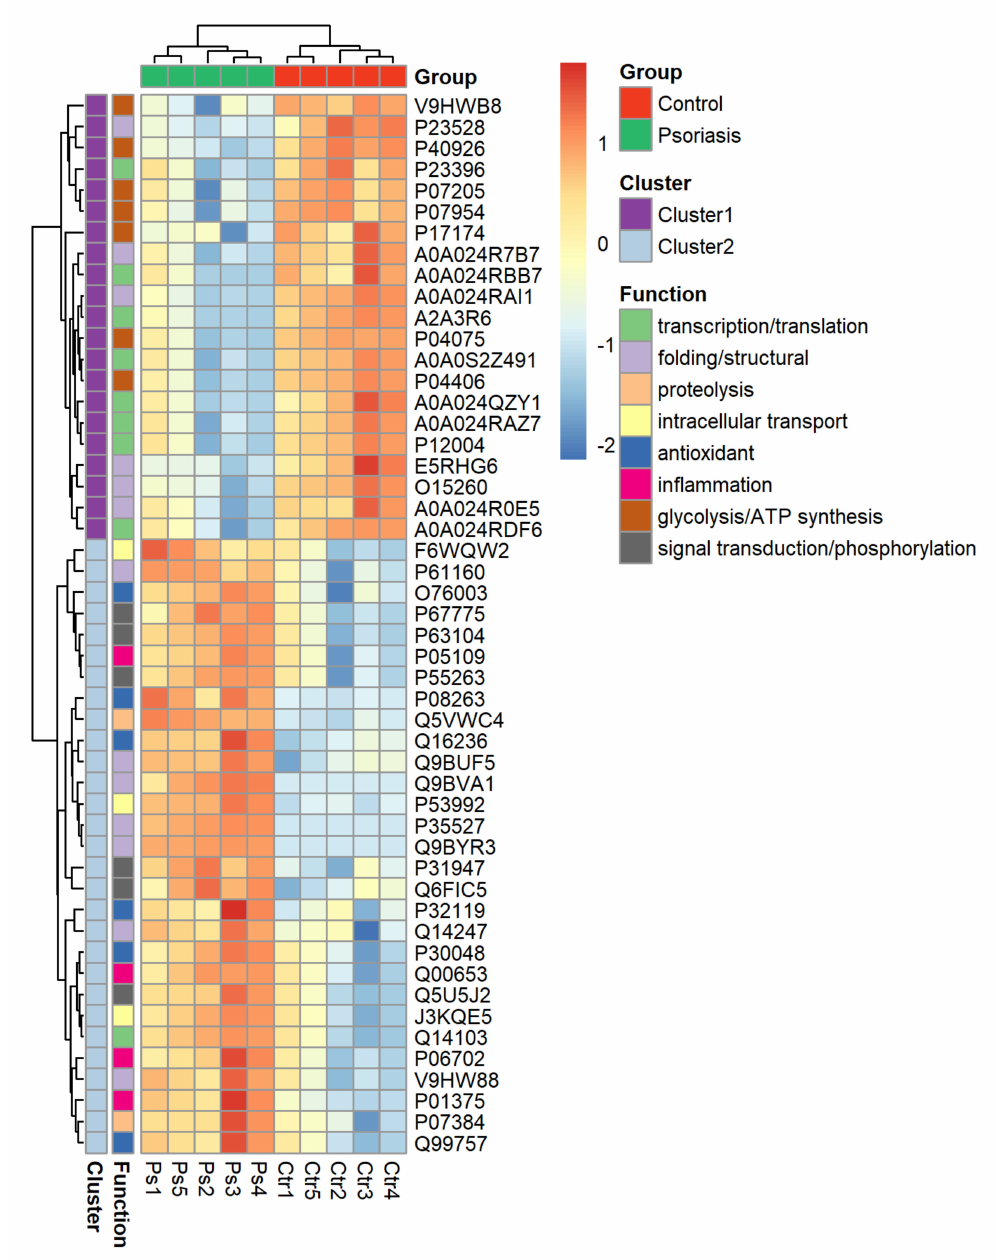
Figure 4. Heat map and clustering of the 50 most significantly changing proteins of fibroblasts isolated from the skin of psoriatic patients ( n = 5) and healthy controls ( n =